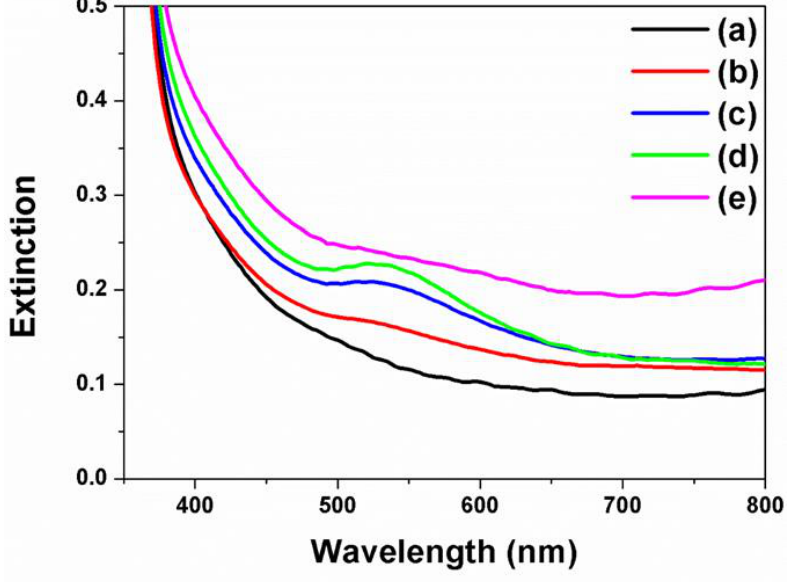
Figure 4. UV-vis absorption spectra of f-TNTAs with Au NPs decorated by electrochemical depo- sition method for (a) 0 s, (b) 10 s, (c) 20 s, (d) 30 s, and (e) 40